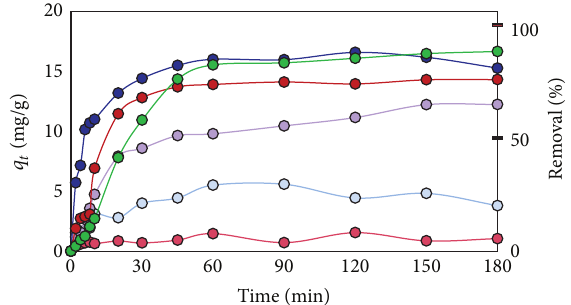
Figure 7: Plot of Cd 2+ adsorption capacity at time ( 𝑞 𝑡 ) and % removal versus adsorption time for effect of various sorbents (RS (light blue), RS-oil 3hr (purple), RS-NaOH 450 W (blue), Bagasse (pink), Bagasse-NaOH 600 W (red), and Dowax (green)).